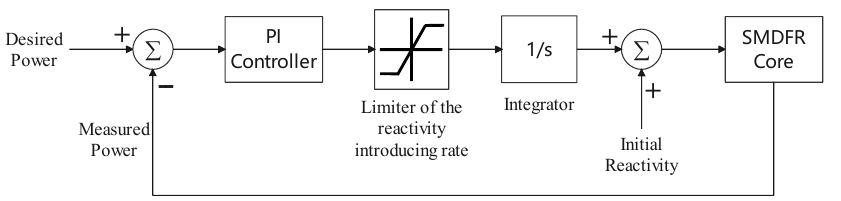
Figure 2. Working principle of the power control